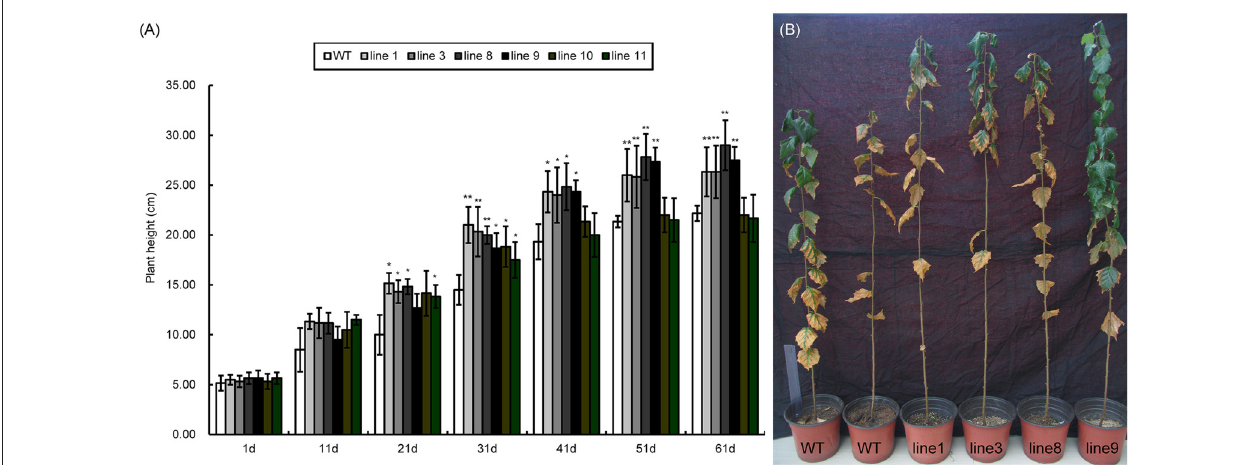
FIGURE 7 | Seedling heights of WT and transgenic lines ( 35S::BpMYB106 ). (A) Seedling heights of 35S::BpMYB106 transgenic lines compared with WT plant from day 1 to 61 under glasshouse conditions. Data accompanied by the same letter indicates no significant difference, and different letters indicate a significant difference ( n = 15 , * P < 0.05 , ** P < 0.01 by two-tailed t -test and one-way ANOVA). Error bars on each symbol indicate the mean ± SE of three replicate reactions. (B) 35S::BpMYB106 transgenic lines to the right of the image shown after 8 months of growth, as compared with two WT plants on the left. WT, wild-type plant; lines 1, 3, 8, 9, 10, and 11; transgenic lines ( 35S::BpMYB106 ).